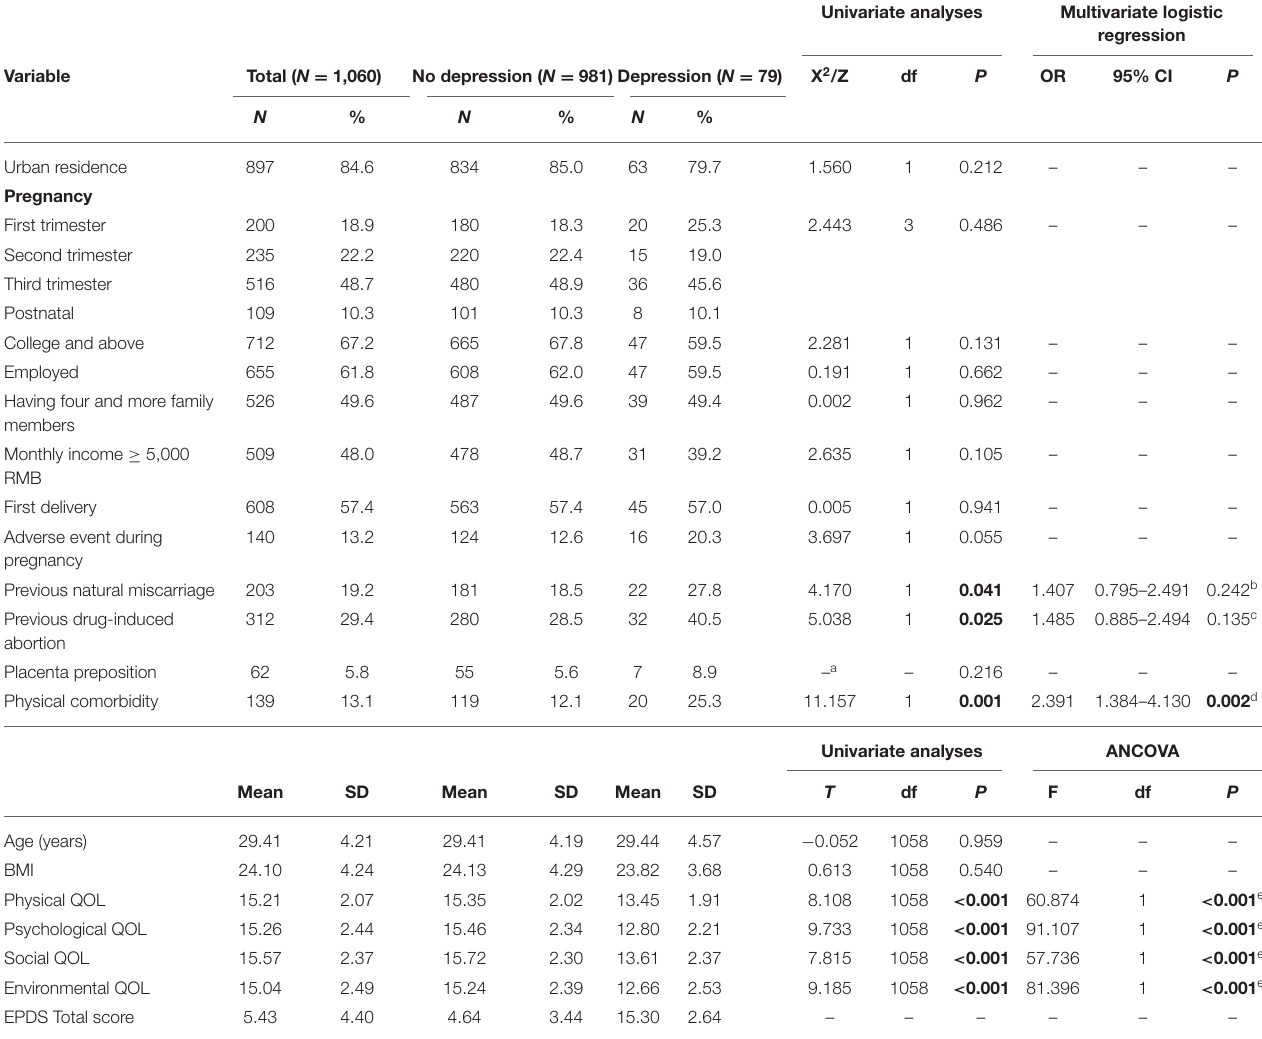
TABLE 1 | Demographic characteristics of the Chinese pregnant women ( N =